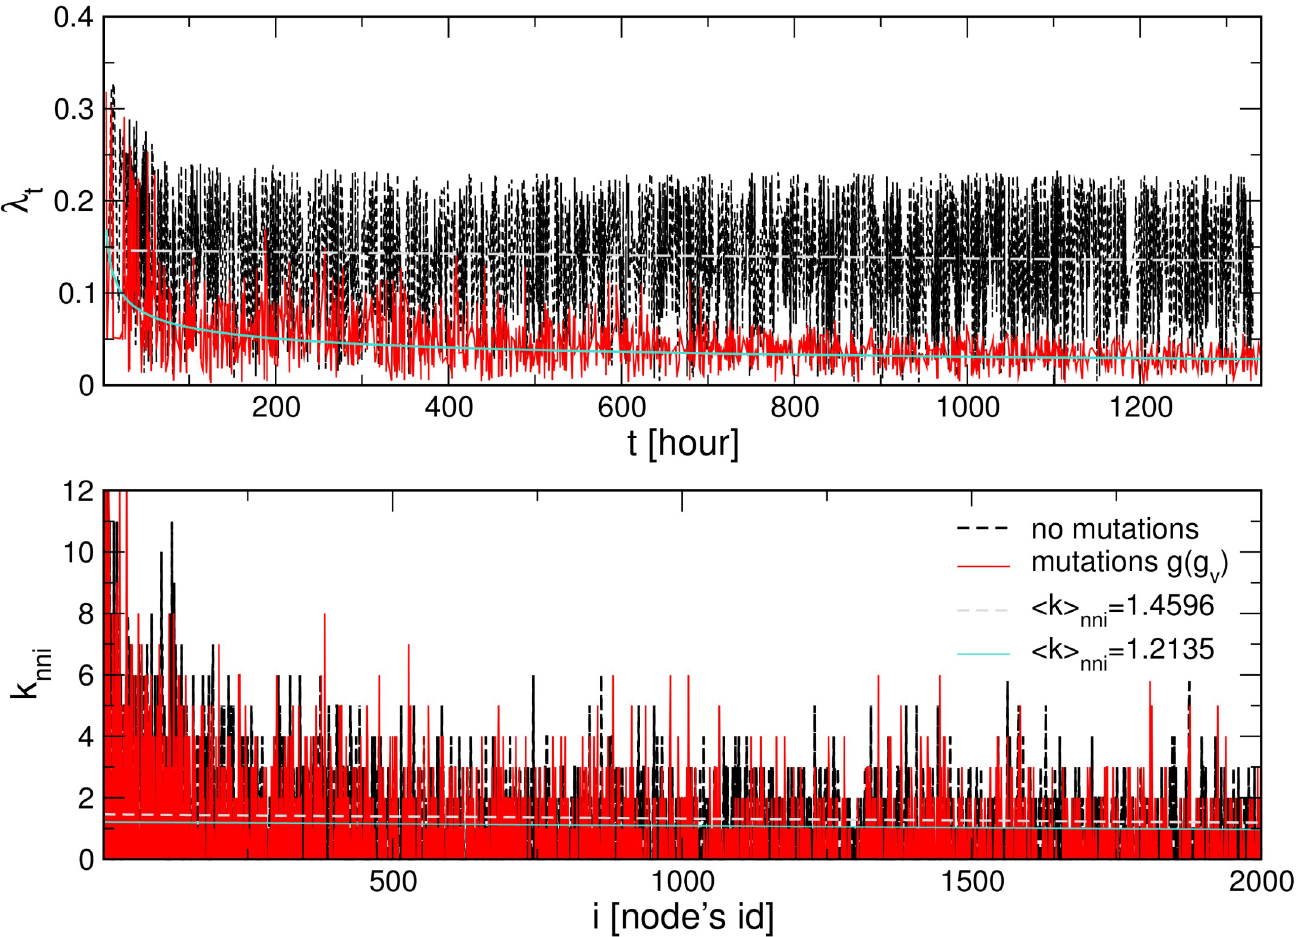
Fig 4. Effective transmissibility. Top: Transmission rate λ t vs time t for the case with the virus mutations (full, red curve) and without mutations (dashed, black curve) for λ 0 = 0.23 corresponding to the course of the process in Fig 3. Bottom: Related to these transmission rates, the number of infected followers k Hnode i indicated along the horisontal axis. For clarity, only the first 2000 nodes are shown.